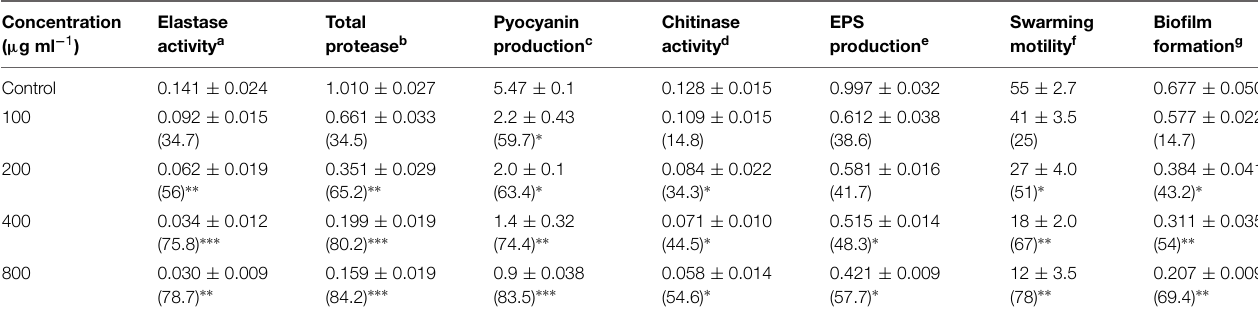
TABLE 4 | Effect of sub-MICs of menthol on inhibition of quorum sensing regulated virulence factors in P. aeruginosa PAO1.